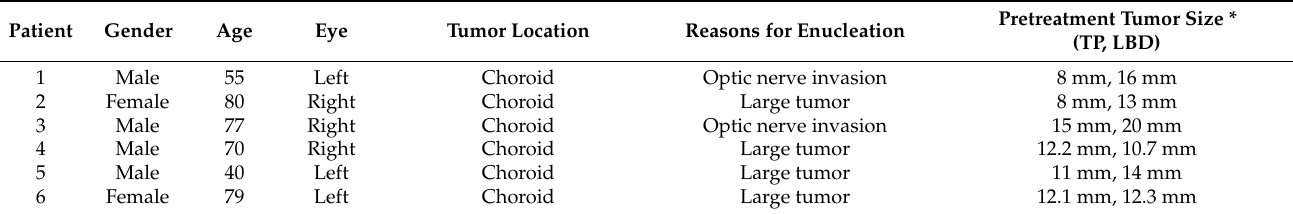
Table 3. Demographic and clinicopathological characteristics of the nonirradiated group.